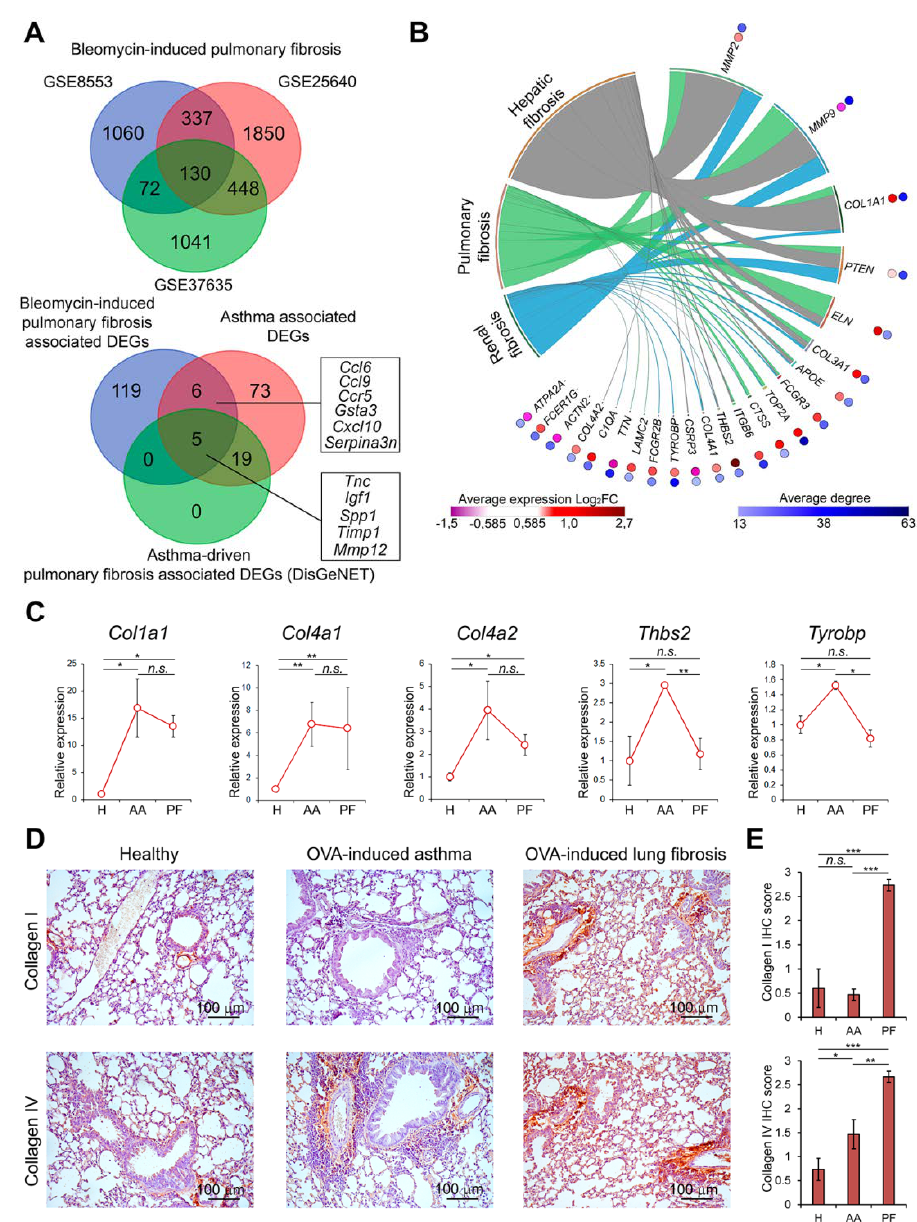
Figure 6. Involvement of genes associated with bleomycin-induced lung fibrosis in the development of asthma and post-asthmatic fibrosis. ( A ) Venn diagram of genes differentially expressed in the lungs of mice with bleomycin-induced pulmonary fibrosis (upper panel). Venn diagram of overlapping genes differentially expressed in the lungs of mice with bleomycin-induced pulmonary fibrosis and top-10 asthma-associated genes with their first neighbors (lower panel). ( B ) Co-occurrence of identified DEGs with keywords associated with pulmonary, hepatic, and renal fibrosis in scientific literature deposited in the MEDLINE database. Analysis was performed using GenClip3 web service. Data were visualized via Circos. Red circles: heat map demonstrating expression levels of DEGs in different GSEs. LogFC = Log 2 (fold change). Blue circles: heat map demonstrating interconnection of DEGs in PPI reconstructed using STRING database (confidence score ≥ 0.7, maximal number of interactors = 0) in Cytoscape. Degree—number of interactions between DEGs and its partners. ( C ) Expression of fibrosis − associated genes in the lungs of healthy mice and mice with OVA − induced asthma (OVA 24 h) and post − asthmatic fibrosis (OVA 4 w). Relative expression levels were normalized to the expression level of hypoxanthine phosphoribosyltransferase ( HPRT ) (used as the reference gene). Three to five samples from each experimental group were analyzed in tripli- cate. The data are shown as mean ± standard deviation. ( D ) Representative immunohistochemical images of lung sections of healthy mice and mice with OVA − induced asthma and post − asthmatic